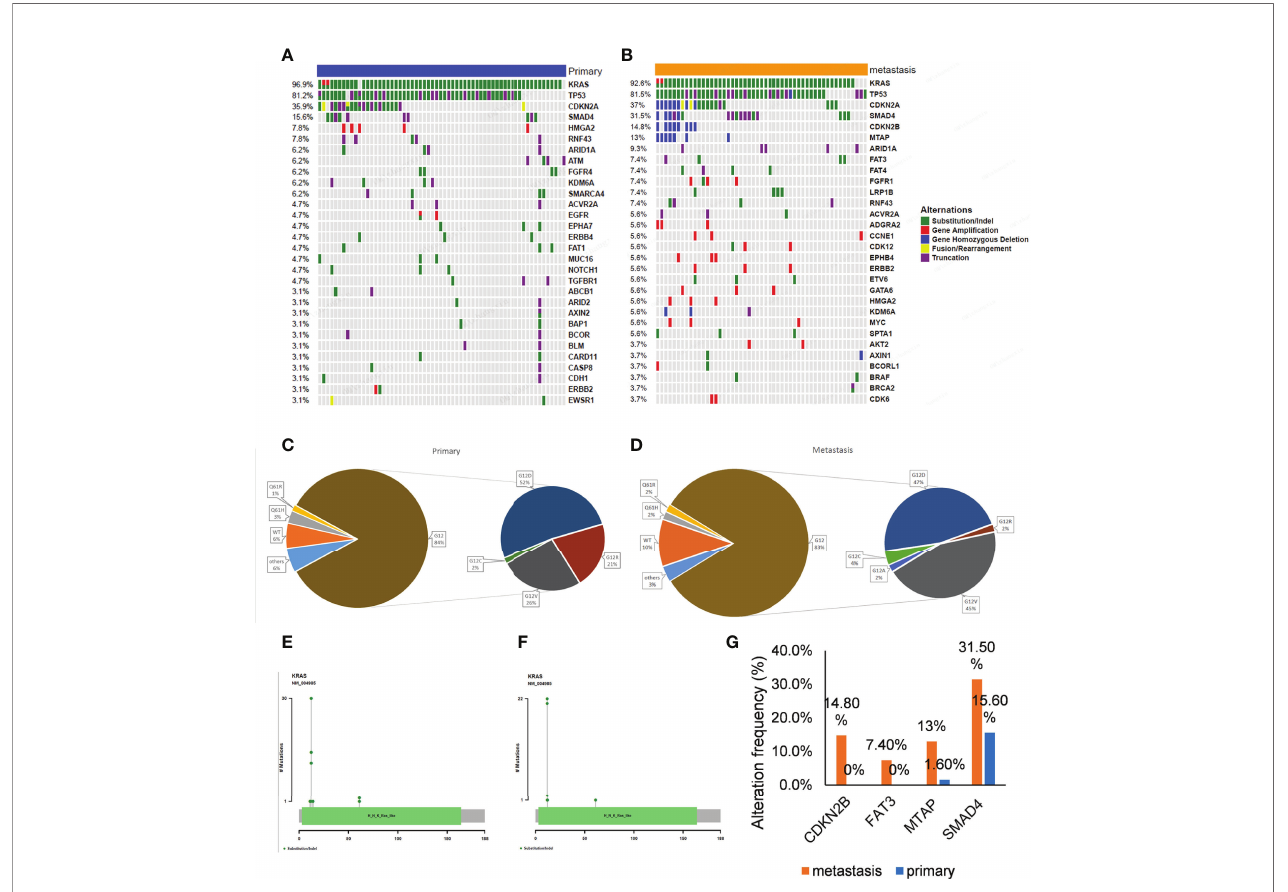
FIGURE 3 | Gene alterations of 64 primary and 54 metastatic tumors. (A, B) The mutation pro fi les. The panel shows the matrix of mutations with each type of mutation in a different color. Each column denotes an individual tumor and each row represents a gene. The right panel shows the name of mutations and the left panel shows the proportion of mutations. Green; Substitution/Indel, Red; Gene ampli fi cation, Blue; Gene homozygous deletion, Yellow; Fusion/Rearrangement, Purple; Truncation. (C, D) Ratio of different mutation types in KRAS gene. (E, F) The distribution map of KRAS gene mutation sites showed the distribution of mutation sites. (G) Genes with a signi fi cant difference in mutation frequency between primary and metastatic